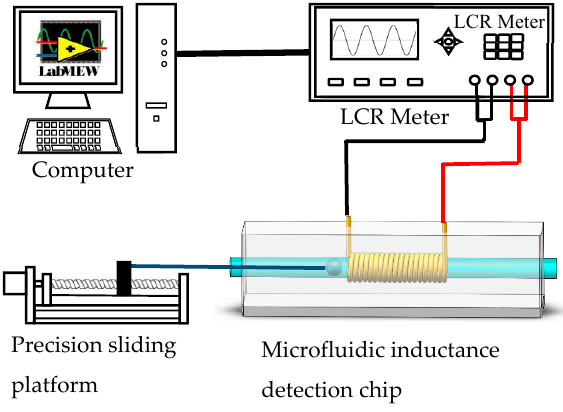
Figure 2. The detection system for single wear debris.